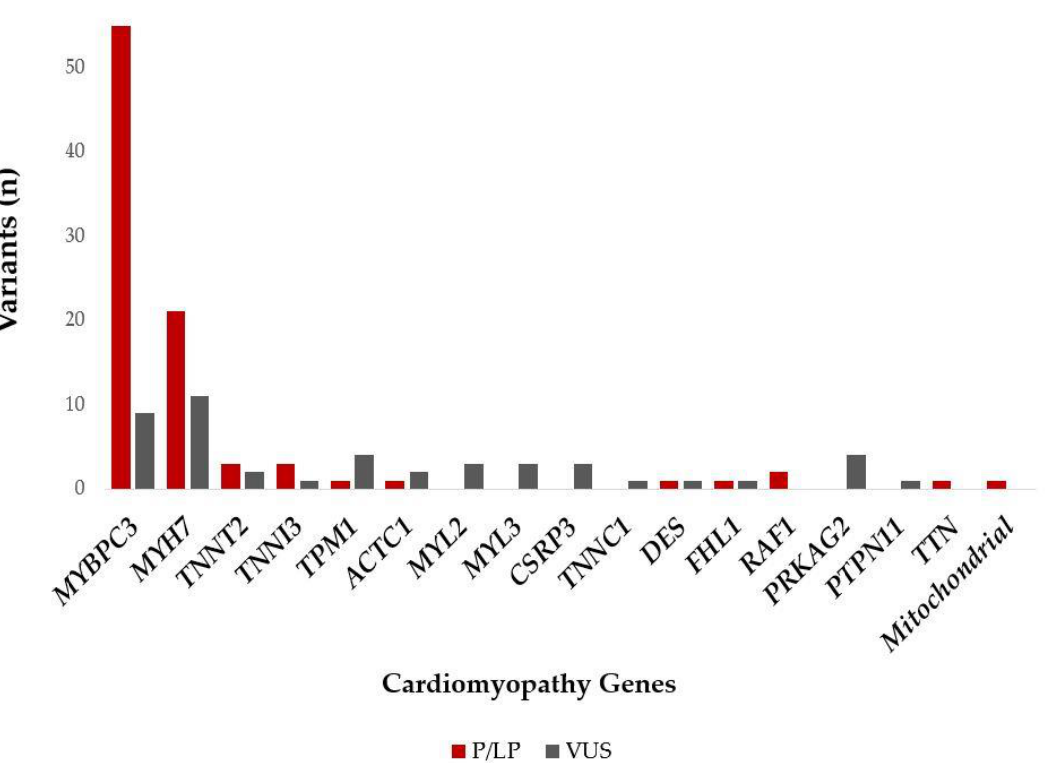
Figure 1. P/LP and VUS (in patients without P/LP variants) variants identified in the different cardiomyopathy genes among the Hungarian HCM patients. Abbreviations: P/LP: pathogenic/likely pathogenic variant; VUS: variant of unknown significance.